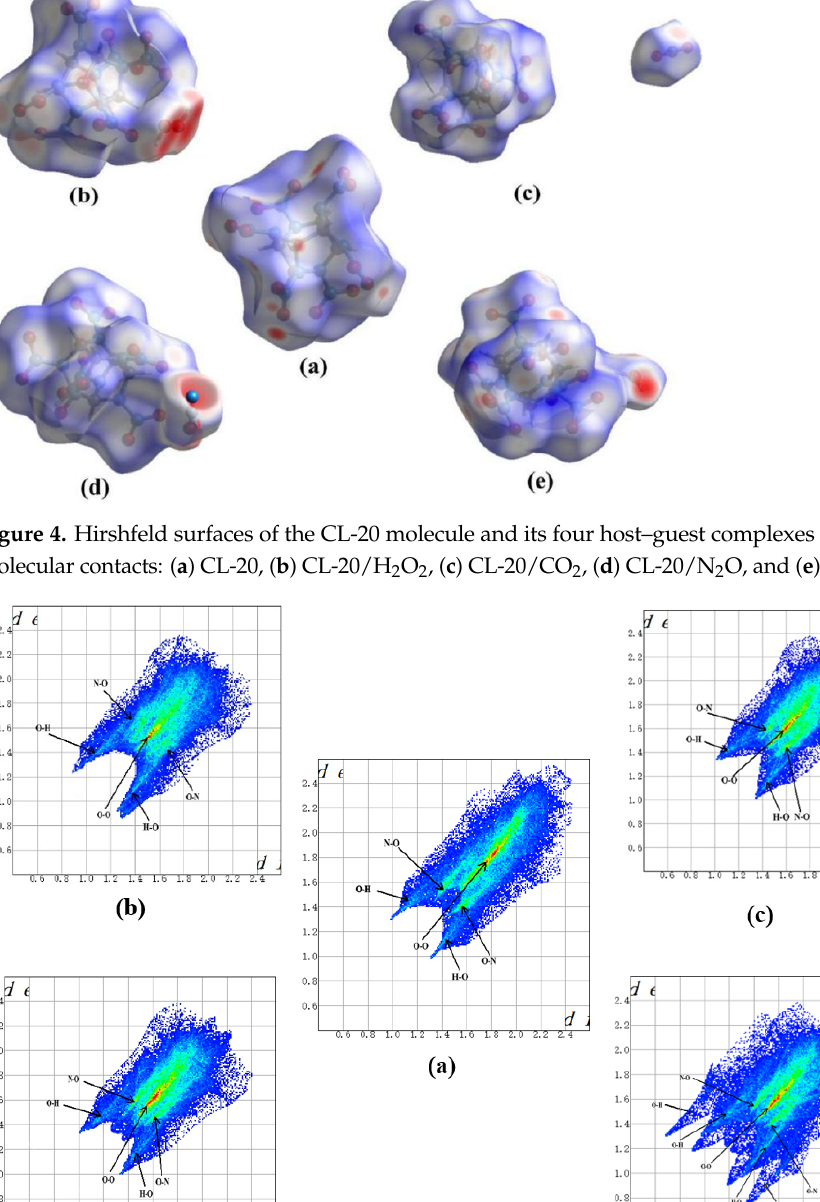
Figure 3. The surface minima and maxima: ( a ) CL-20, ( b ) CL-20/H 2 O 2 , ( c ) CL-20/CO 2 , ( d ) CL-20/N 2 O, and ( e ) CL-20/H 2 O. Red and blue spheres represent the position of maxima and minima, respec- tively.